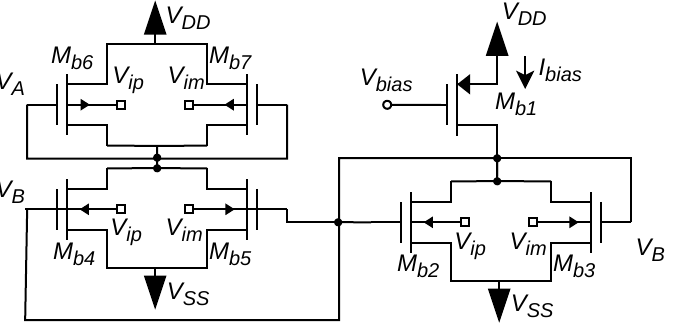
Figure 2. Schematic of the proposed replica bias circuit to set the common mode current of the input